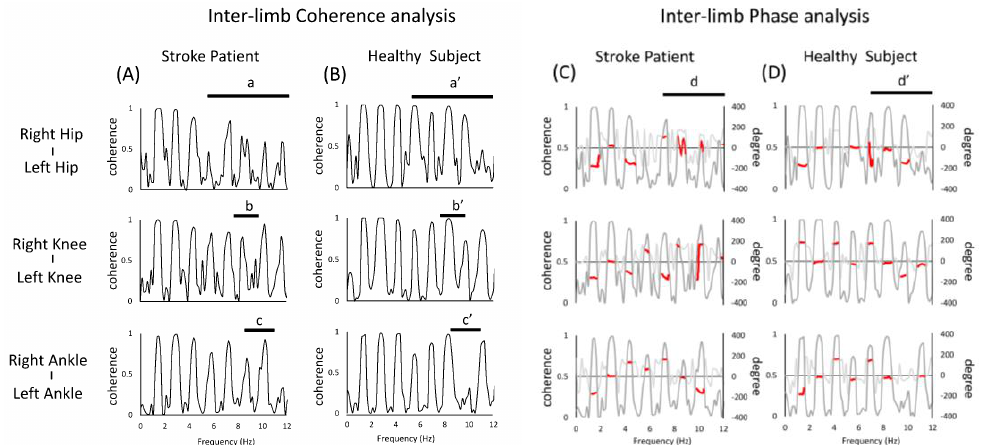
Figure 2. Diagram of coherence analysis and phase analysis between inter-limbs. The figure ( A , B ) shows the results of the coherence analysis. The figure ( C , D ) shows the results of the phase analysis overlaid with the results of the coherence analysis (gray line). When the peak coherence is greater than 0.3, the phase results are partially shown with red lines. The top, middle, and bottom rows show the hip, knee, and ankle joint pairs, respectively. In the figure, (a,a’), (b,b’), (c,c’) shows coherence analysis, (d,d’) shows the different parts of the phase analysis between stroke patient and healthy subject.